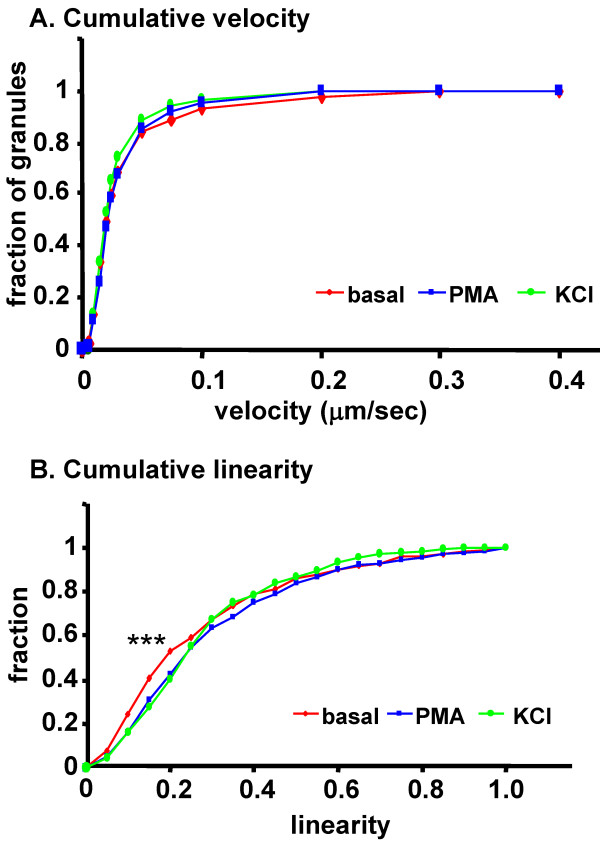
Secretagogues increase linearity but not cumulative velocity in axons. LDCVs containing PHM-GFP were imaged in the presence of PMA or KCl; the effects of secretagogue on dynamics were compared to behaviors observed under basal conditions. LDCV velocity and linearity were assessed in axons; data for each treatment group were pooled from 6 cells each. The distribution of cumulative velocity (A) and linearity (B) is shown for LDCVs under basal conditions and during stimulation with PMA and KCl. Both PMA and KCl had a significant effect (p < 0.01) on linearity, but not on velocity.